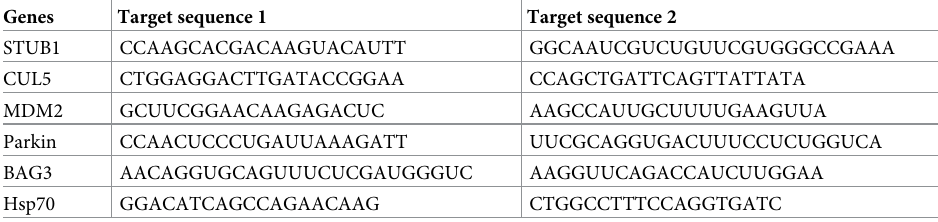
Table 2. The siRNA sequences used in the